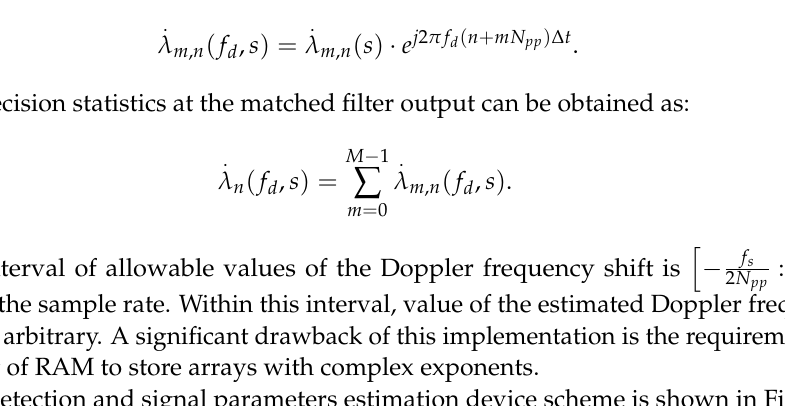
Figure 2. Matched filter with a series of sequences with complex exponents.